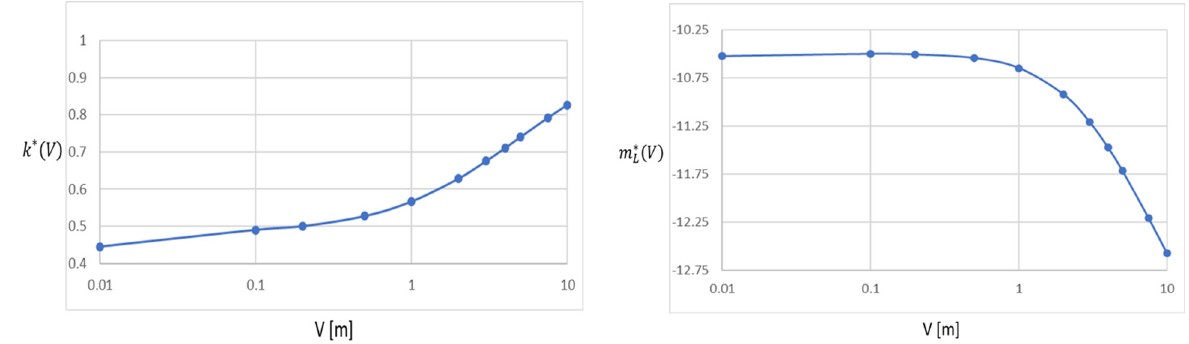
Figure 2. The effect of solidification velocity on the partition coefficient and liquidus slope for IN718.